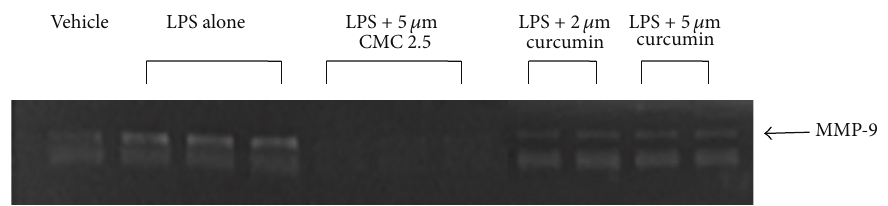
Figure 5: Inhibition of MMP-9 levels by CMC 2.5 in PBMC cells. PBMC cells (5 × 10 5 cells/well) were cultured in serum-free media (37 ∘ C, 95% air, 5% CO 2 ) for 18 hours with LPS ( P. gingivalis , 50ng/mL) or vehicle alone. CMC 2.5 was added at a final concentration of 5 𝜇 M. Conditioned medium was analyzed for MMP-9 by gelatin zymography.